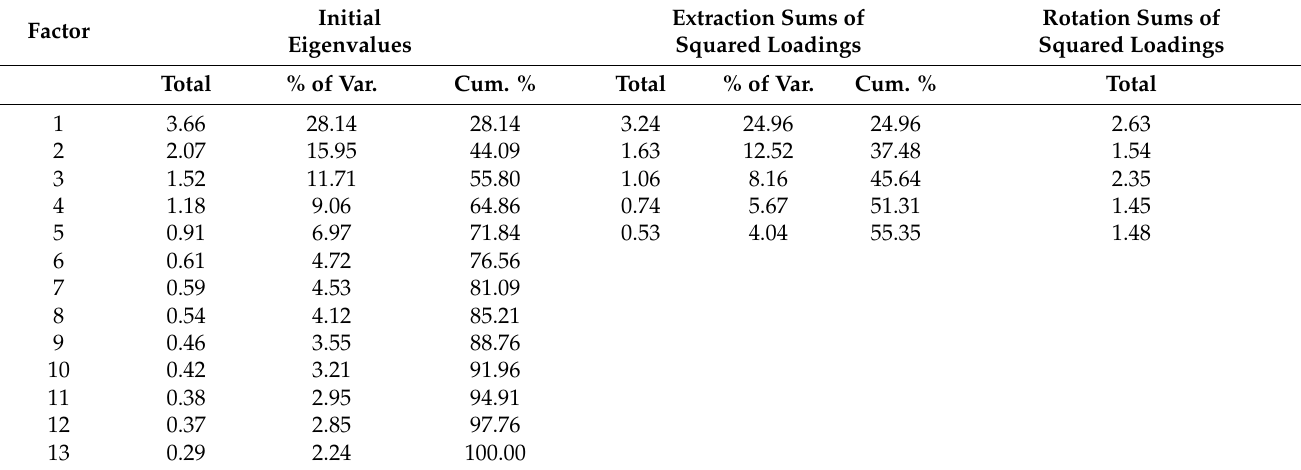
Table 2. EFA–total variance